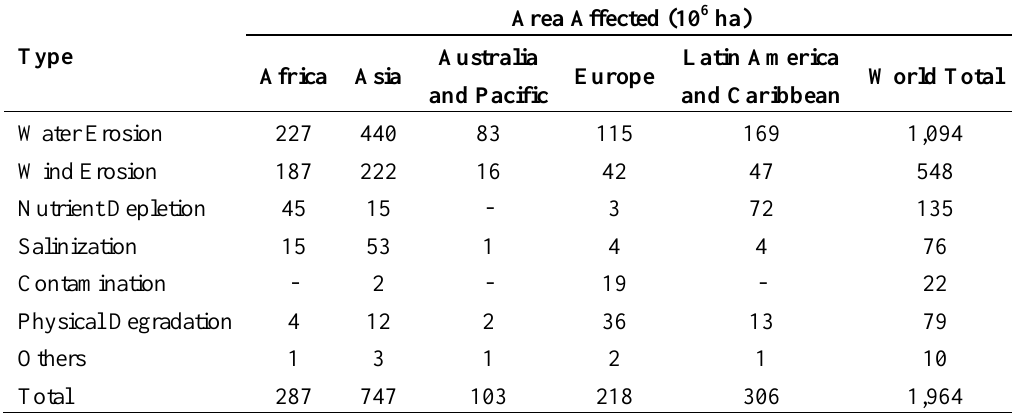
Table 4. Estimates of anthropogenic soil degradation (recalculated from